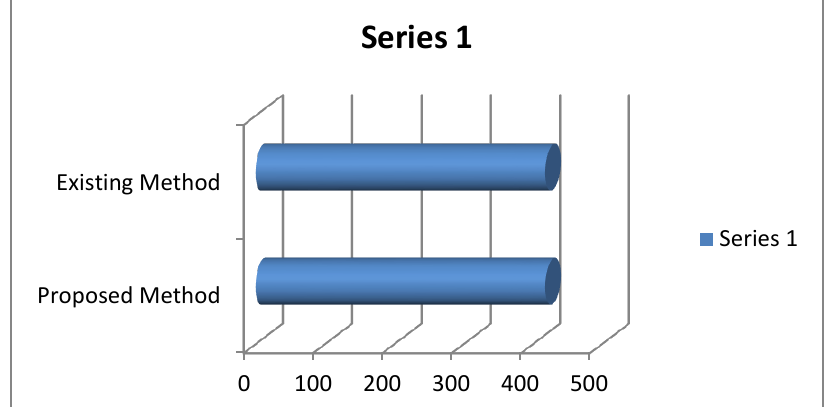
Fig. 1. Graphical analysis of our proposed method with existing method of example 1.